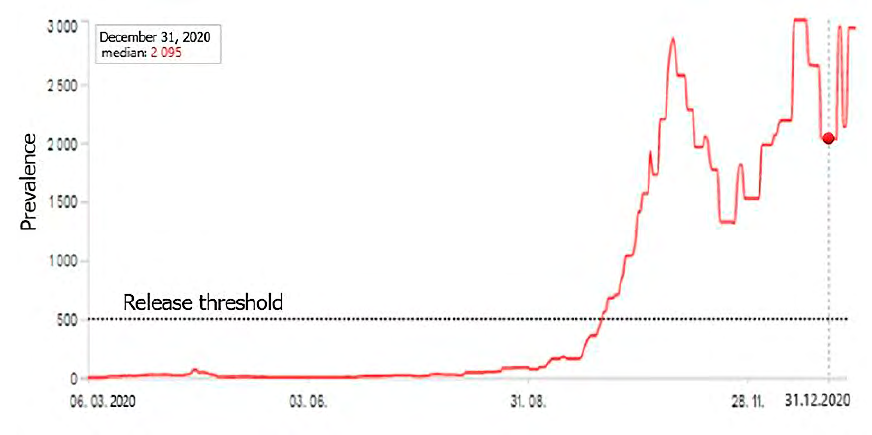
Figure 3. Seven-day sliding median